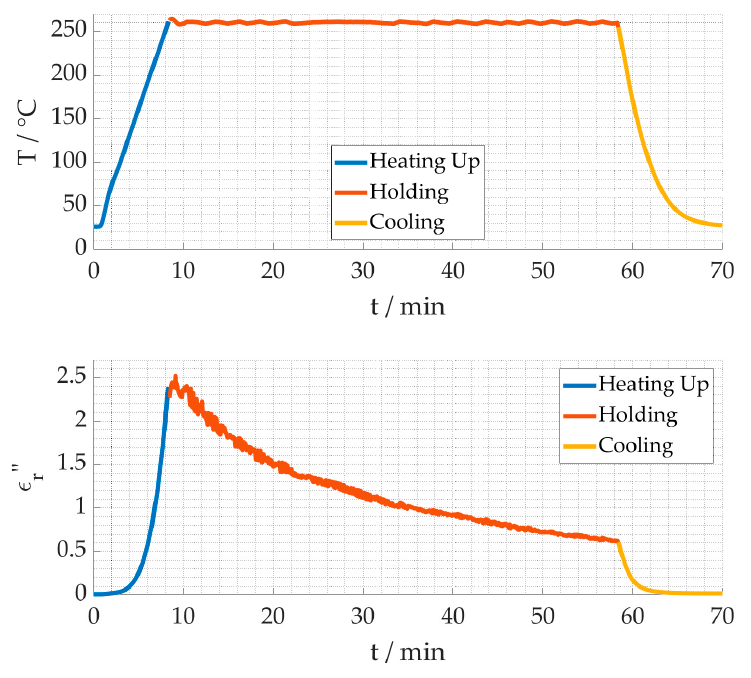
Figure 5. Dielectric loss for a process time of 50 min and at a process temperature of 260 °C. The loss factor (cid:101) (cid:48)(cid:48) is measured with an accuracy of ± 0.0017 for the virgin PAN fiber at room temperature. The worst case for the accuracy of the heated fiber is ± 0.14. It is caused by a decrease in the sample quality factor Q s resulting in an increase of Equation (3). The stabilized fiber is measured at room temperature with an accuracy of ±